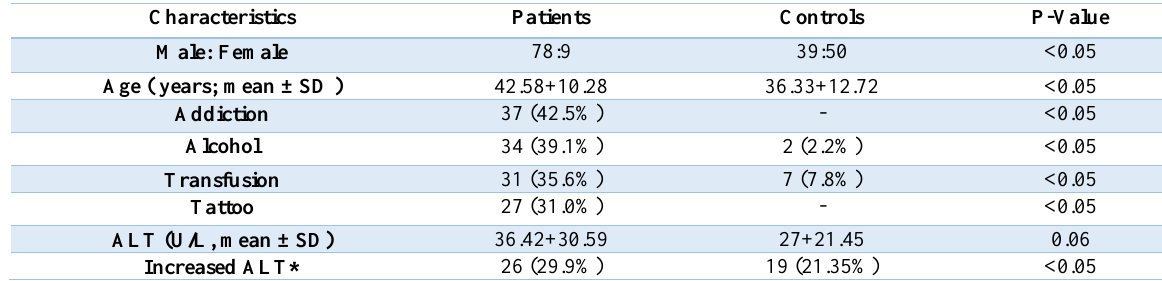
Table 1. Information on demographic and risk factors in the studied population of HCV patients and control groups